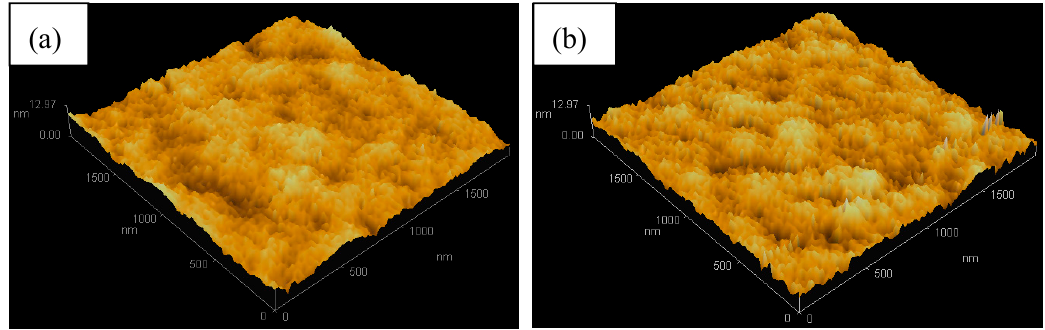
Figure 8. Atomic Force Microscopy (AFM) images of the surfaces of the phase-change microcapsules (microPCMs): ( a ) S0 and ( b ) S4.